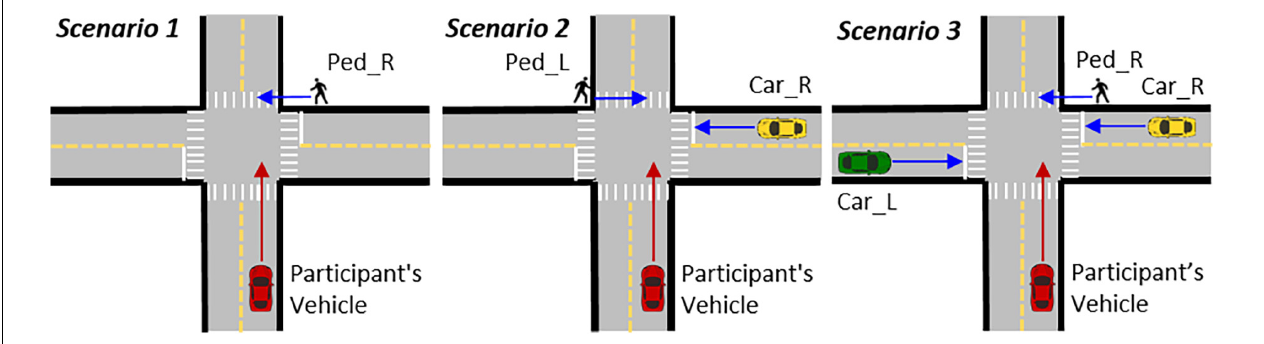
FIGURE 3 | Schematic of each of the three types of intersection scenarios. Each scenario included a pedestrian on either the left or right side. Scenario 1 (left) had no cross traffic and a pedestrian on either the left or right, shown here with a pedestrian on the right (Ped_R). Scenario 2 (middle) included a cross-traffic vehicle approaching from one side only with a pedestrian on the opposite side, shown here with a car from the right (Car_R) and a pedestrian on the left (Ped_L). Scenario 3 (right) included cross traffic from both the left (Car_L) and right (Car_R) sides at the same time with a pedestrian on either the left or right, shown here with a pedestrian on the right (Ped_R).